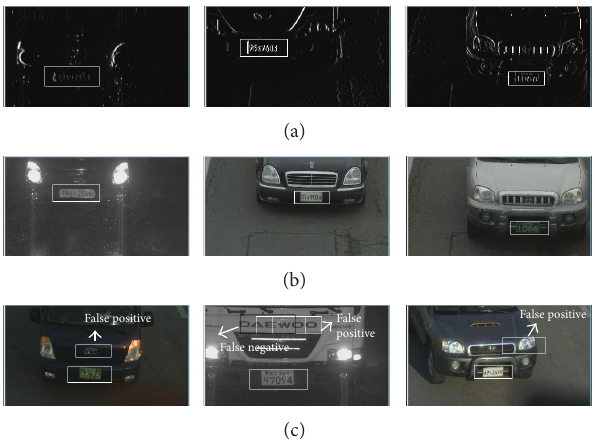
Figure 15: Results of LPD using cascade AdaBoost: (a) examples of LPD with edge images, (b) examples of LPD with resized images, and (c) examples of LPD with false